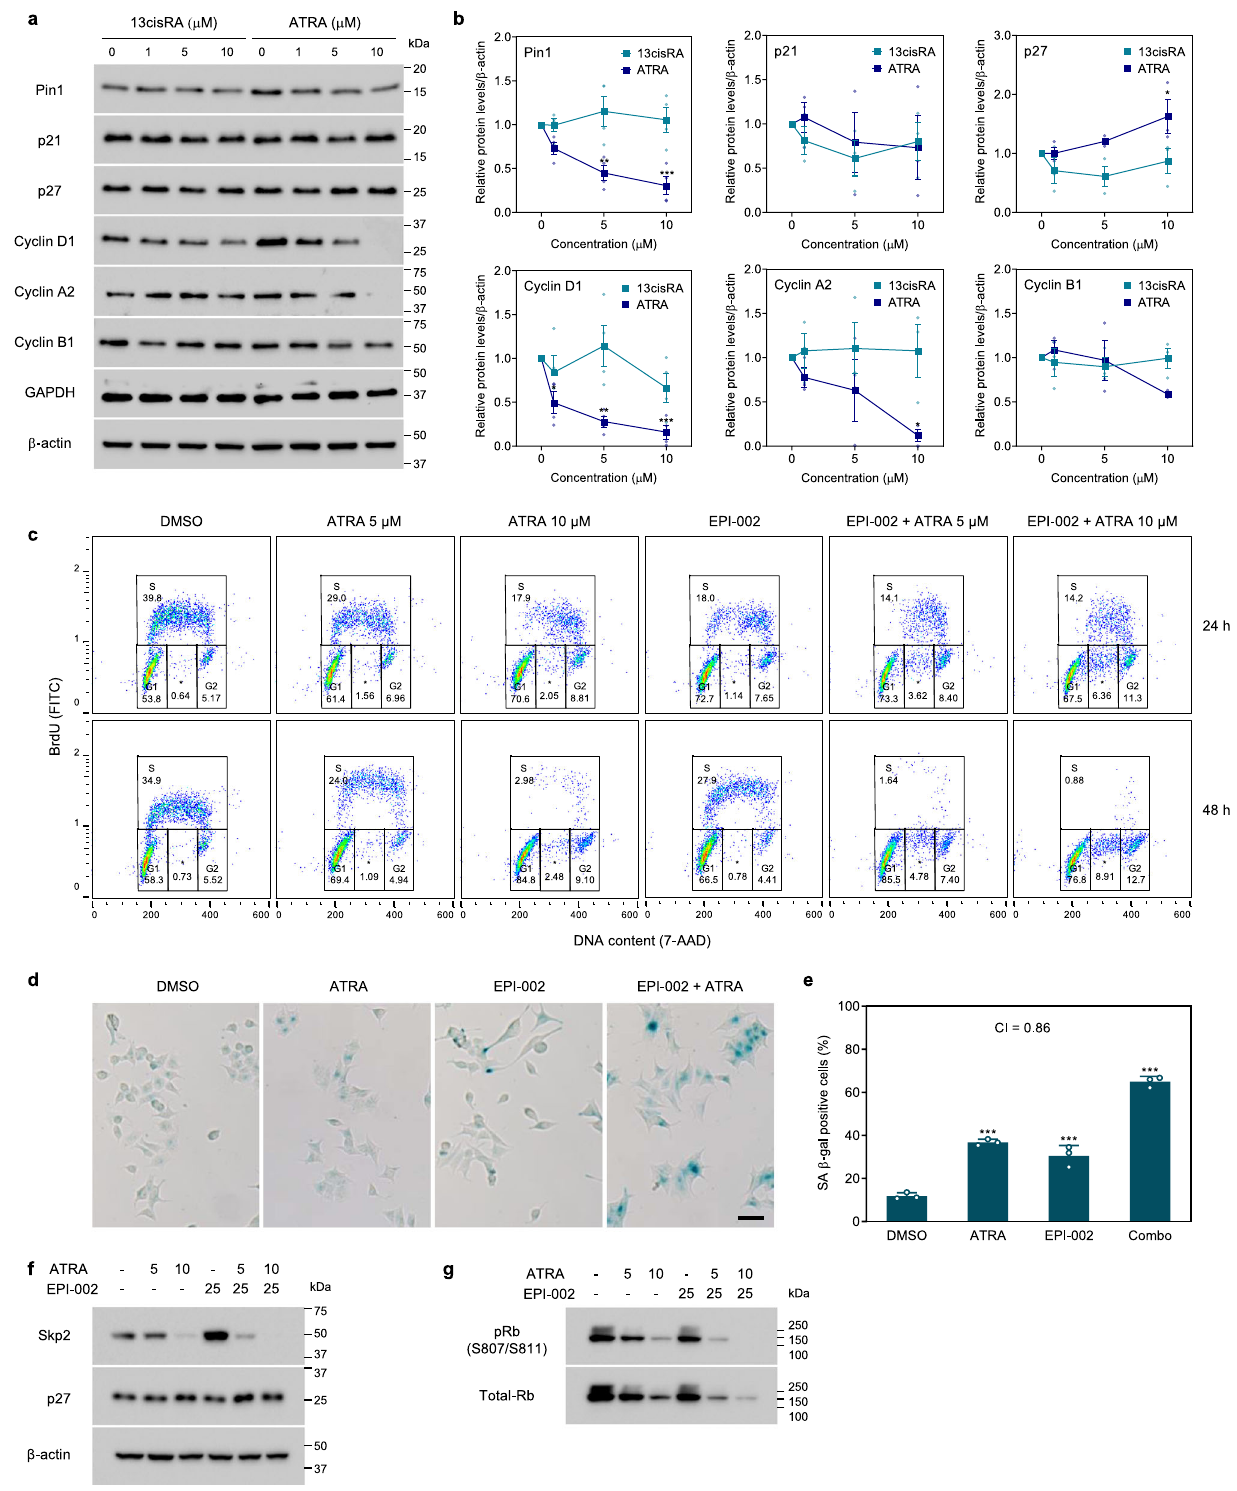
Fig. 6 ATRA and EPI are synergistic in blocking cell cycle progression. a Expression of cell cycle proteins from lysates of LN95 cells treated with 0 – 10 µ M of ATRA or 13cisRA. b Graphs show the quanti fi ed levels of the indicated proteins after normalizing to β -actin ( n = 4). c Cell cycle analysis of LN95 cells treated with vehicle (DMSO), ATRA (5 or 10 μ M), EPI-002 (25 μ M), or combinations for 24 or 48 h in media supplemented with 1.5% CSS. BrdU-negative S phase cells are denoted by asterisk (*). d Staining of SA β -gal activity performed on LN95 cells after incubating with ATRA (10 μ M), EPI-002 (25 μ M), ATRA (10 μ M), or a combination for 3 days. Original magni fi cation: ×100. The scale bar represents 50 µ m. e The graph shows the percentage of β -gal- positive cells scored from at least 1000 cells for each treatment group from three independent experiments. f , g Representative immunoblots showing the expression of indicated cell cycle proteins after incubating with combination therapy. Data shown are the means ± s.e.m. from 3 – 4 independent experiments. Statistical signi fi cance was determined by ANOVA using the Dunnett ’ s multiple comparisons test. * P < 0.05, ** P < 0.01, *** P <